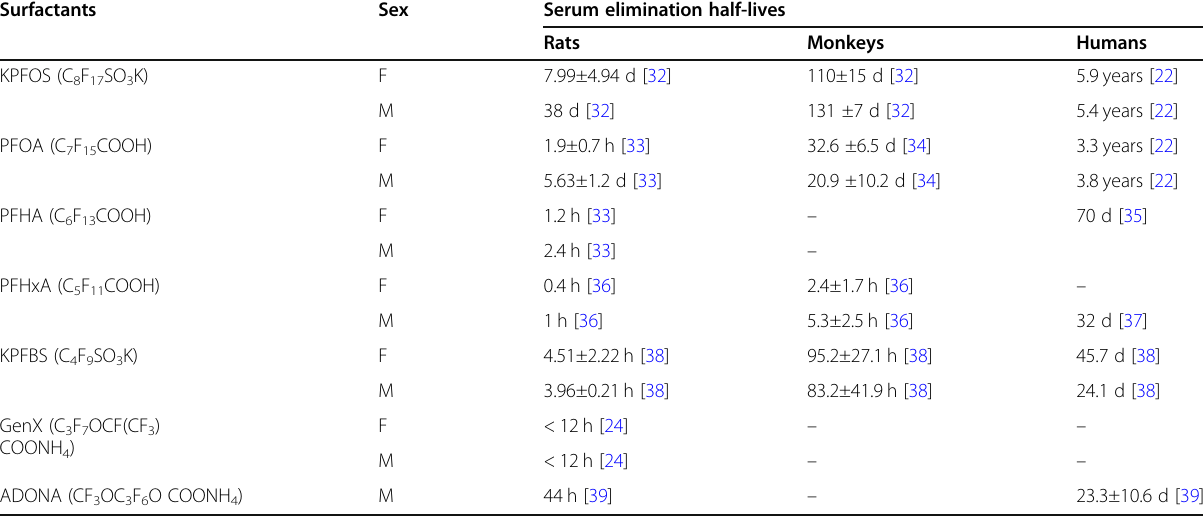
Table 2 Serum elimination half-lives of some fluorinated surfactants (KPFOS, PFOA, perfluoroheptanoic acid (PFHA), perfluorohexanoic acid (PFHxA), potassium perfluorobutylsulfonate (KPFBS), ammonium 2,3,3,3-tetrafluoro-2-(heptafluoropropoxy) propanoate acid (GenX) and ammonium 4,8-dioxa-3H-perfluorononanoate (ADONA)) in female (F) and male (M) rats, monkeys and humans